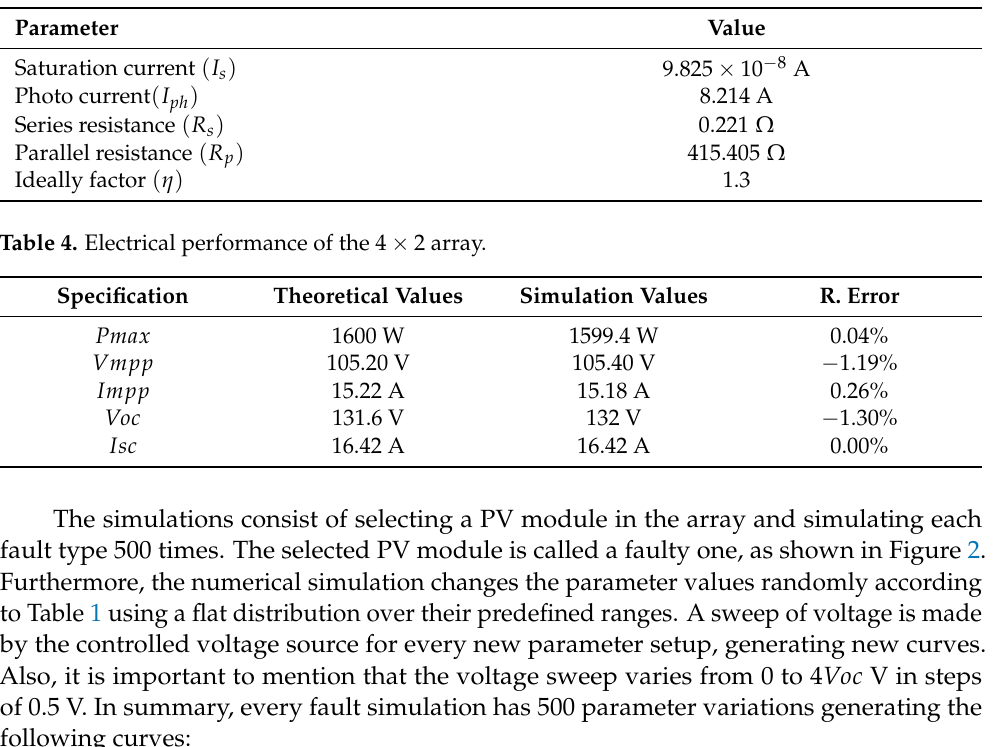
Table 3. Values of the five-parameter model of the KC200GT [41].